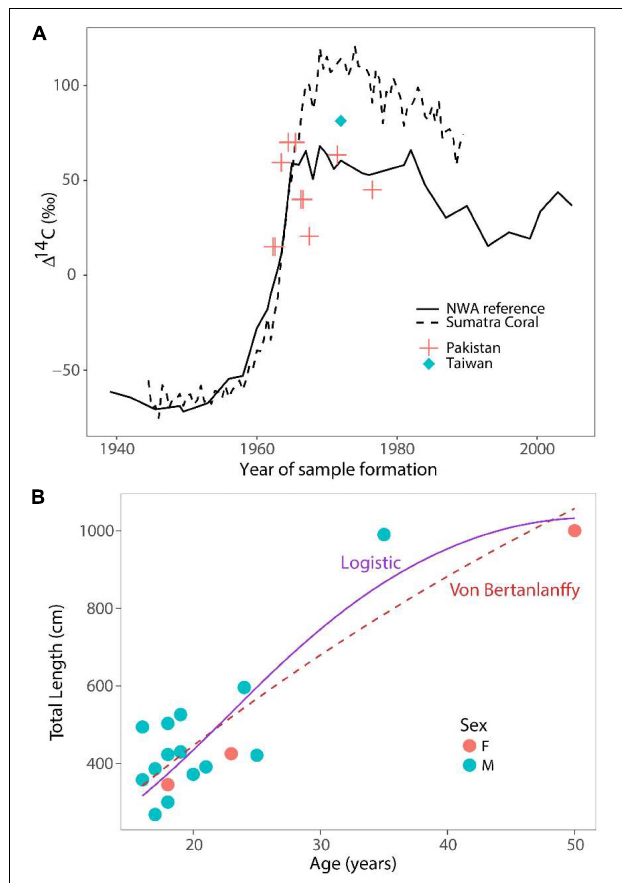
FIGURE 2 | Results of bomb radiocarbon assays and growth models. (A) Bomb radiocarbon ( (cid:49) 14 C) results of whale shark vertebrae from two locations (Pakistan – red crosses; Taiwan – blue diamond) compared to two reference chronologies (carbonate surface water reference from north west Atlantic – solid line; coral reference from Sumatra – dashed line). (B) Length-at-age data fitted with logistic (solid purple) and von Bertanlanffy (dashed red) growth models. Data pooled between sexes for both